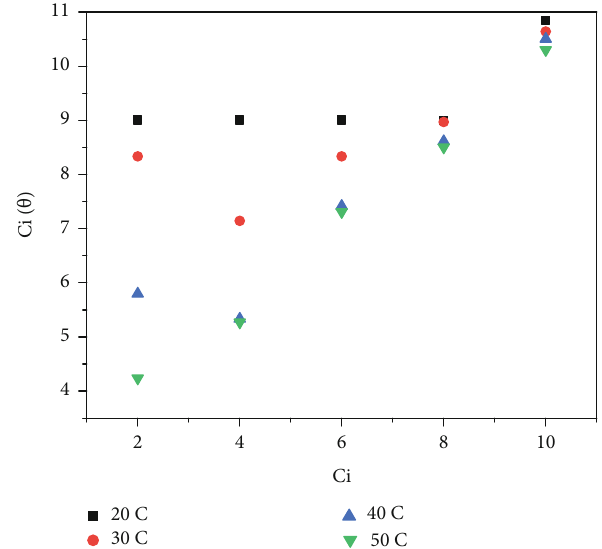
Figure 5: Langmuir adsorption isotherm of PDL extract for aluminium corrosion in 1 M hydrochloric acid at di ff erent